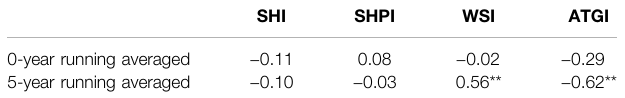
TABLE 2 | Correlation coef fi cients between PDO and each meteorological index. SHI SHPI WSI ATGI 0-year running averaged